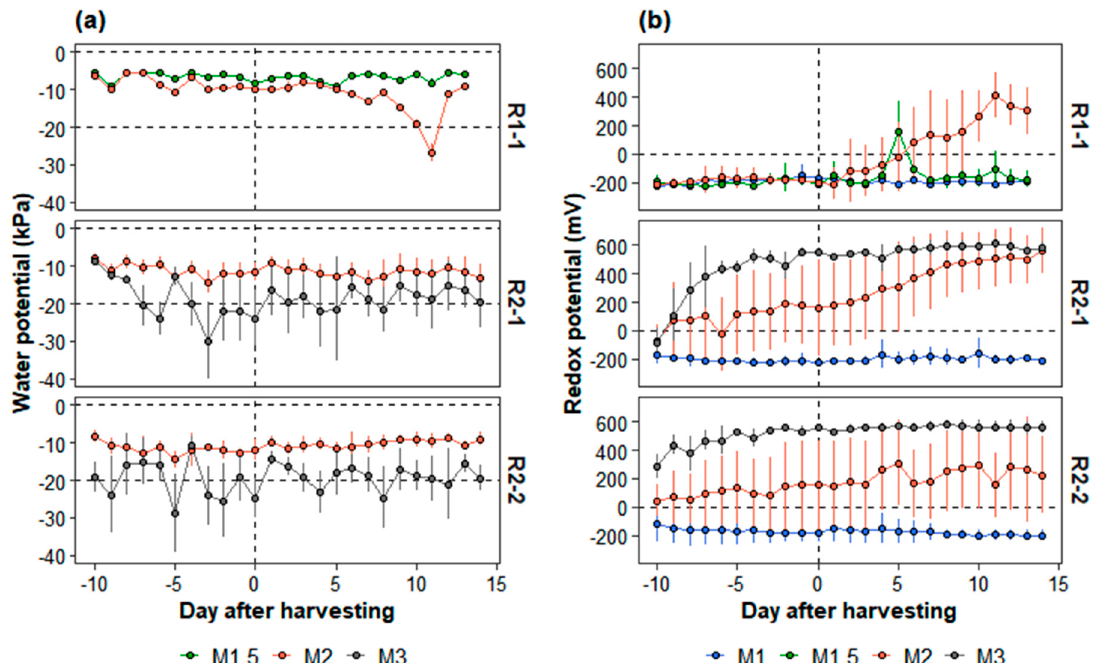
Figure 1. Changes in ( a ) soil water potential and ( b ) redox potential in selected tanks under different moisture regimes before and after harvest of the main crop. R1-1, R2-1, and R2-2 represent first ratoons of the first main crop and first and second ratoons of the second main crop, respectively. M1, M2, and M3 represent the saturated, humid, and dry soil moisture regimes, respectively. M1.5 is between M1 and M2. Data represent the mean ± standard deviation. Sample size of ( a ) n = 2 for R1-1, n = 8 for R2-1 and R2-2, ( b ) n = 9 for all ratoons. Dashed horizontal lines indicate 0 and − 20 kPa for ( a ) and 0 mV for ( b ); vertical lines represent the day of harvest.